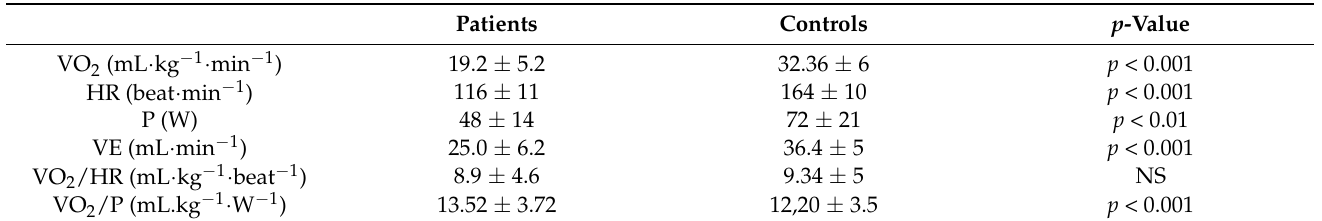
Table 3. Sub maximal parameters of the exercise capacity scored at ventilatory thresholds.